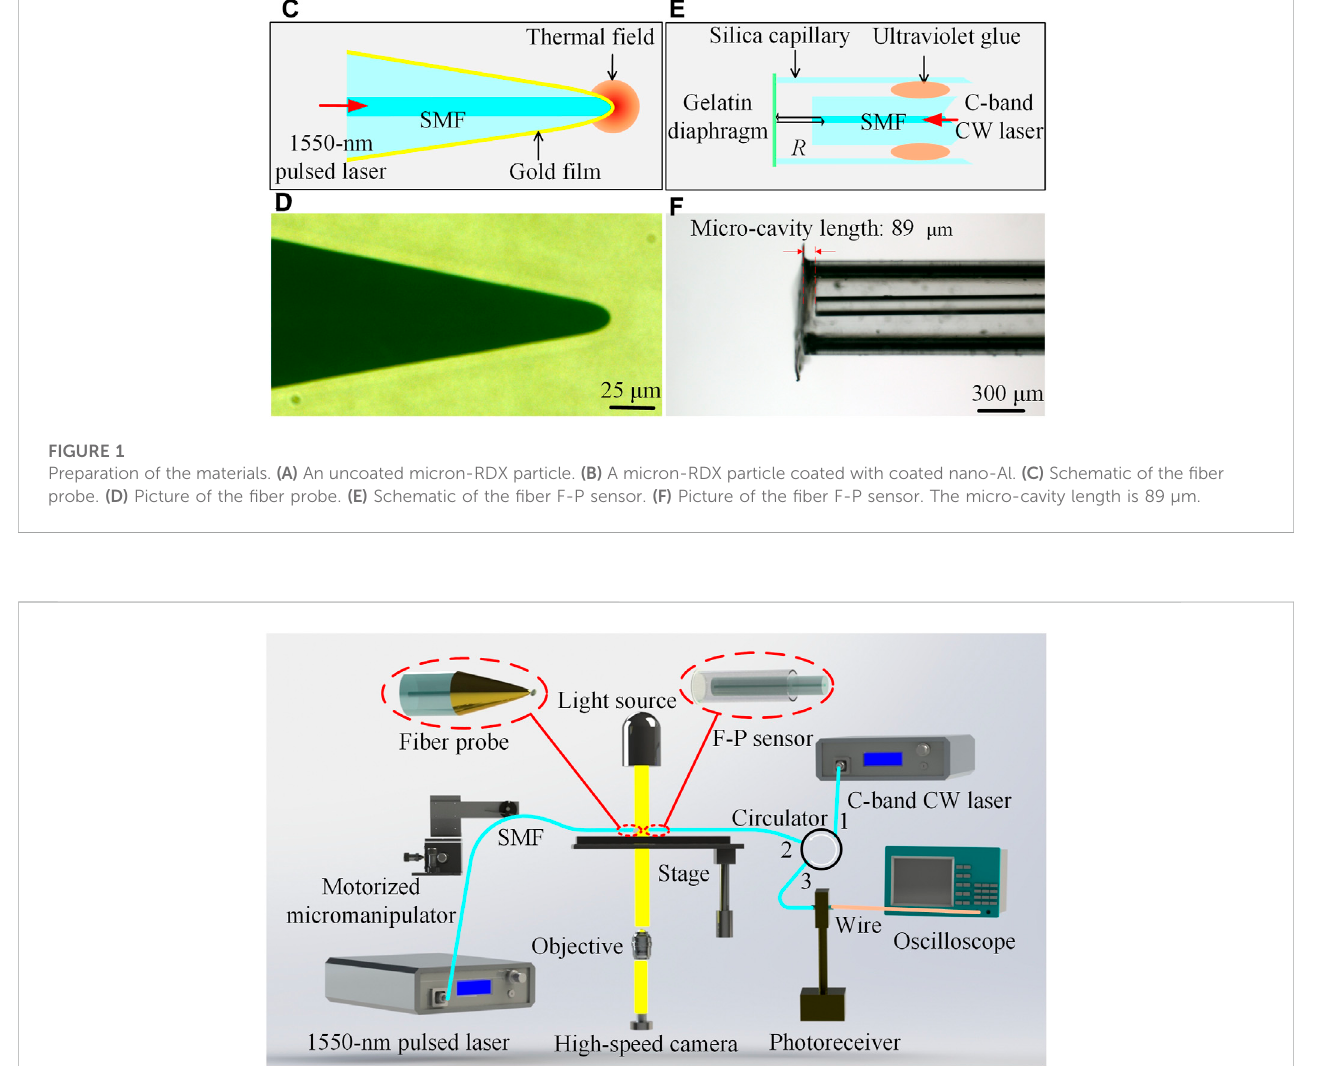
The pressure sensing module is composed of the fi ber F-P pressure sensor, a C-band wavelength-tunable continuous wave (CW) laser (VLSP-C-M-TL, Connet), a circulator, an InGaAs photoreceiver (Model 2117-FC, New Focus), and a digital storage oscilloscope (SDS6000A, Siglent). The CW laser ’ s single-mode pigtail (SMF-28, Corning) and the fi ber sensor are spiced to Port 1 and Port 2 of the circulator, respectively. The photoreceiver and Port 3 of the circulator are connected. The laser is pumped into the microcavity of the fi ber